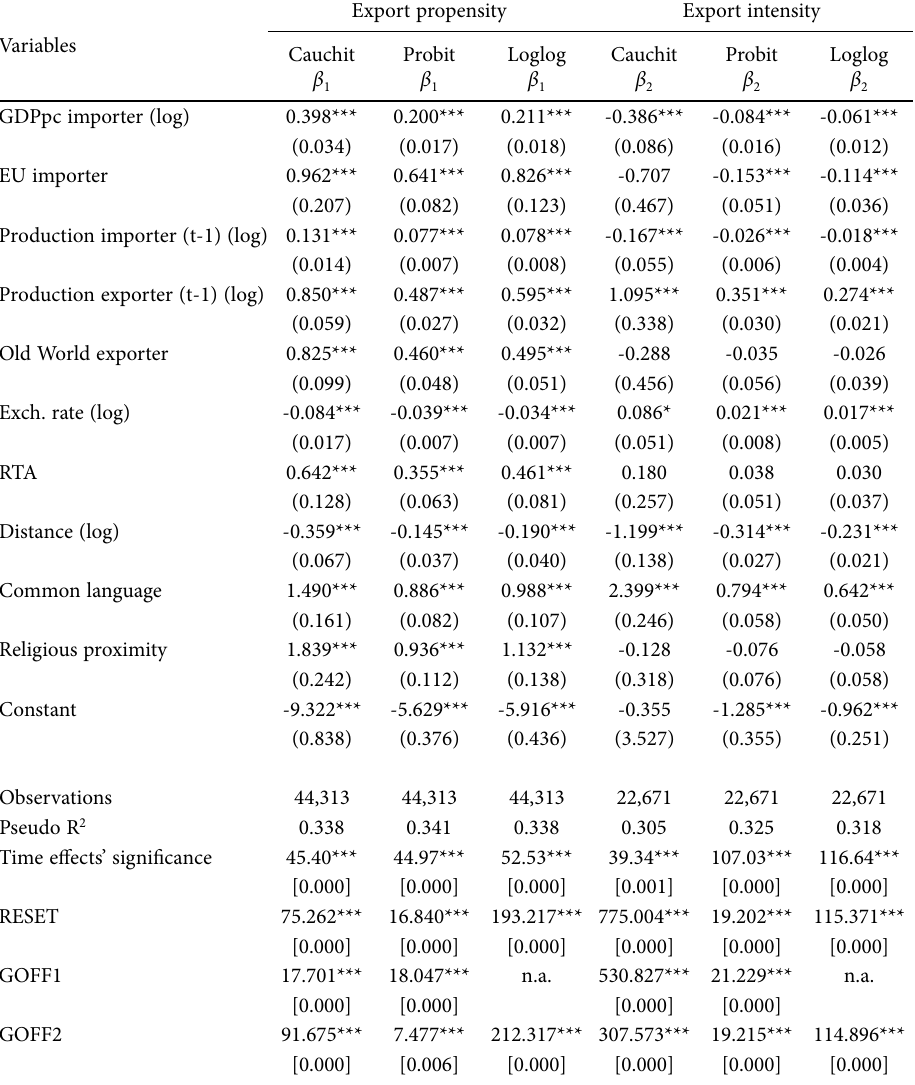
Table A.2. Alternative functional form specifications of the 1 st and 2 nd parts of 2P-FRM